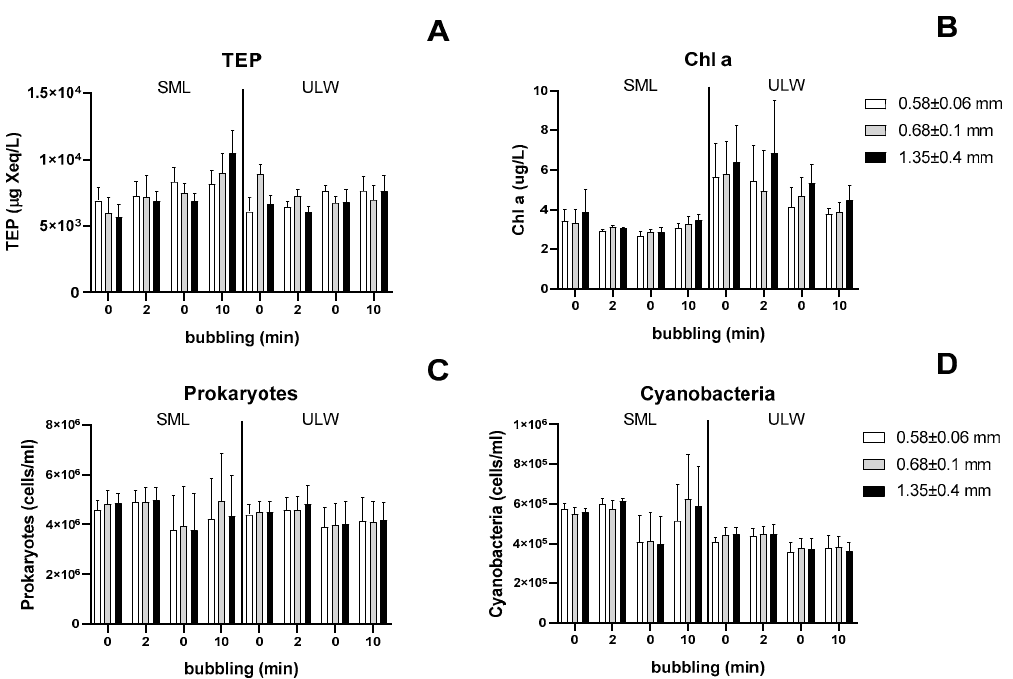
Figure 3. Total concentrations from initial sampling (0), after 2 min bubbling (2), initial sampling again (0), after 10 min (10) bubbling for TEP ( A ), Chlorophyll a ( B ), heterotrophic prokaryotes ( C ) and cyanobacteria ( D ). Results are grouped into SML samples (left) and ULW samples (right). Legend shows the average ± SD diameter of bubbles.